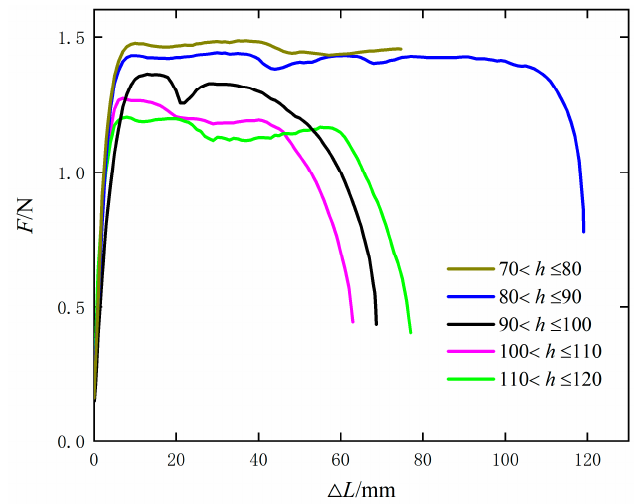
Figure 1. Tensile Force–Deformation Curve.